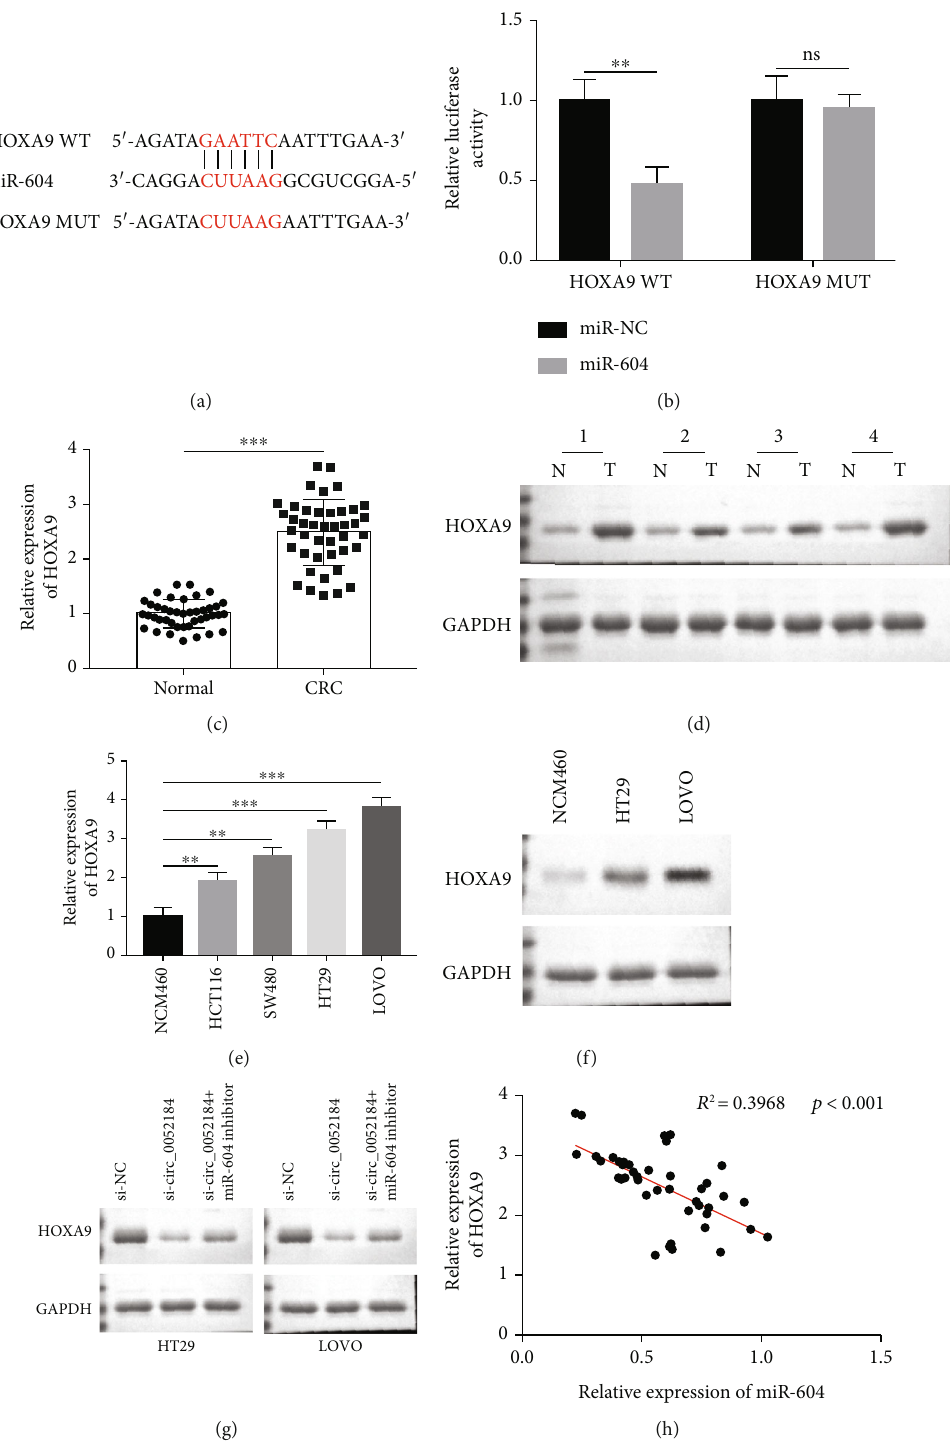
Figure 5: circ_0052184 regulated HOXA9 expression by targeting miR-604. (a) starBase was used to predicted the complementary sequence between miR-604 and HOXA9 3 ′ UTR. (b) Dual-luciferase reporter gene assay was used to con fi rm the binding relationship between miR- 604 and HOXA9. (c, d) HOXA9 mRNA and protein level were measured by qRT-PCR (c) and Western blot (d) in CRC tissues. (e, f) HOXA9 mRNA and protein levels were measured by qRT-PCR (e) and Western blot (f) in CRC cell lines. (g) The protein expression of HOXA9 was measured by Western blot in CRC cells transfected with control siRNA (si-NC), circ_0052184 siRNA (si-circ_0052184), or cotreated with si-circ_0052184 and inhibitors of miR-604, respectively. (h) Pearson correlation between HOXA9 mRNA expression and miR-604 expression in CRC tissues. ∗ p < 0 : 05 , ∗∗ p < 0 : 01 , ∗∗∗ p < 0 : 001